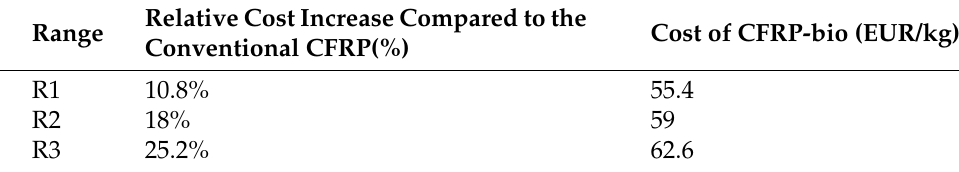
Table 14. Parameters used for sensitivity analysis of the repair business of paddle shifter made from CFRP-bio. The conventional CFRP cost is 50 EUR/kg.